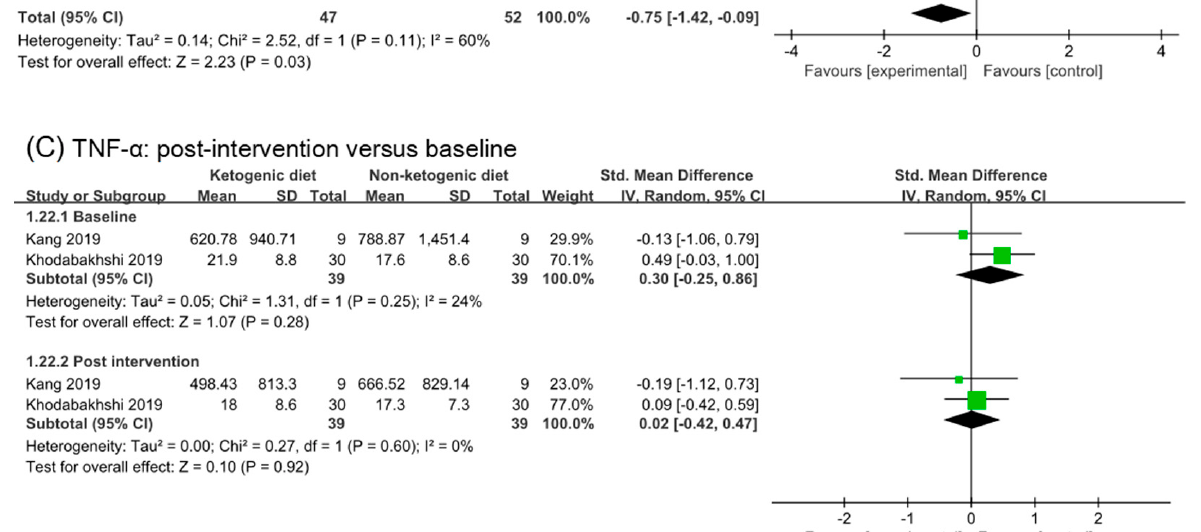
Figure 9. Forest plot for the effects of ketogenic diets on free T3 and TNF- α . ( A , C ) were subgroup effects of the baseline versus post-intervention on free T3 and TNF- α ; ( B ) was the effect of change from baseline on free T3 [30–33,36,37,41,42].